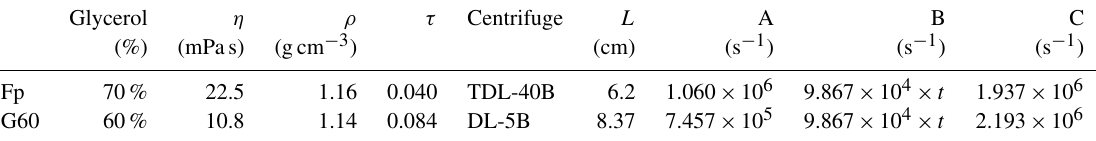
Table 1. The settings of two tests: the density and viscosity of glycerol at 20 ◦ C; data are from Dorsey (1940); the parameters of the centrifuge employed in this study are the following: Fp and G60 represent the experiments carried out with F. profunda in 70% glycerol and small Gephyrocapsa ( < 3µm) in 60% glycerol, respectively; L represents the minimum rotation radius of centrifugation, which represents the distance between the shaft and top of suspension as illustrated in Fig. 1. A, B and C are the terms on the left-hand side of the equal to sign in Eqs. (8)–(10).